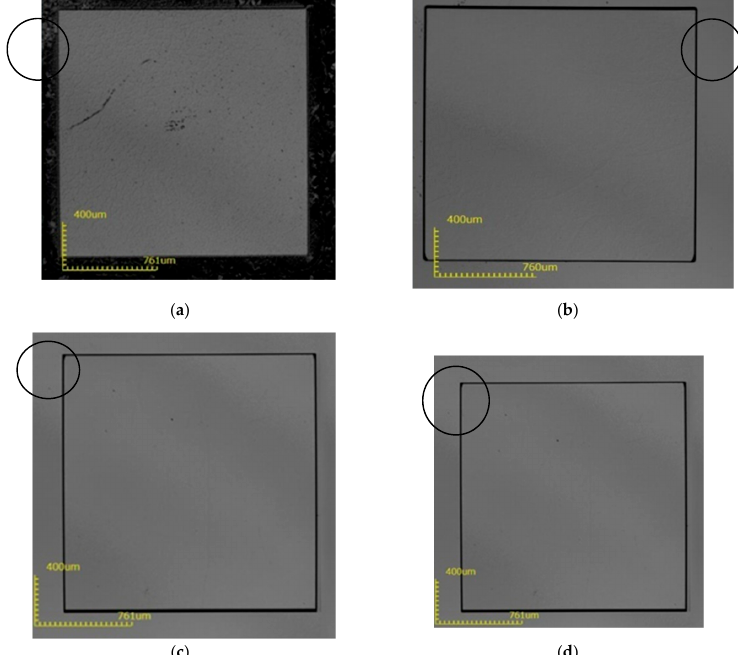
Table 4. Process results at 275 °C . Figure 5. The surface state of the substrate after removing the mask layer after etching at 250 °C , ( a ) 1-2#; ( b ) 2-2#; ( c ) 3-2#; ( d ) 4-2#. It can be seen from Figure 6 that at 275°C, the mask area of sample 1 is completely corroded, and the other three sample mask areas are completely protected. At 275 °C, the corrosion depth can reach 49 μ m, as seen in Table 4.